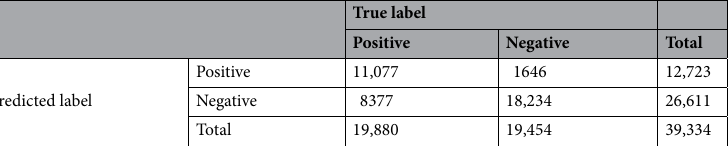
Table 3. Random forest classifier performance on test data, having been trained on an equally sized partition of training data. The high false negative rate of predictions is largely due to tweets which do not contain relevant tokens in spite of local weather conditions. In contrast, relatively few tweets contain relevant tokens without corresponding local winds.